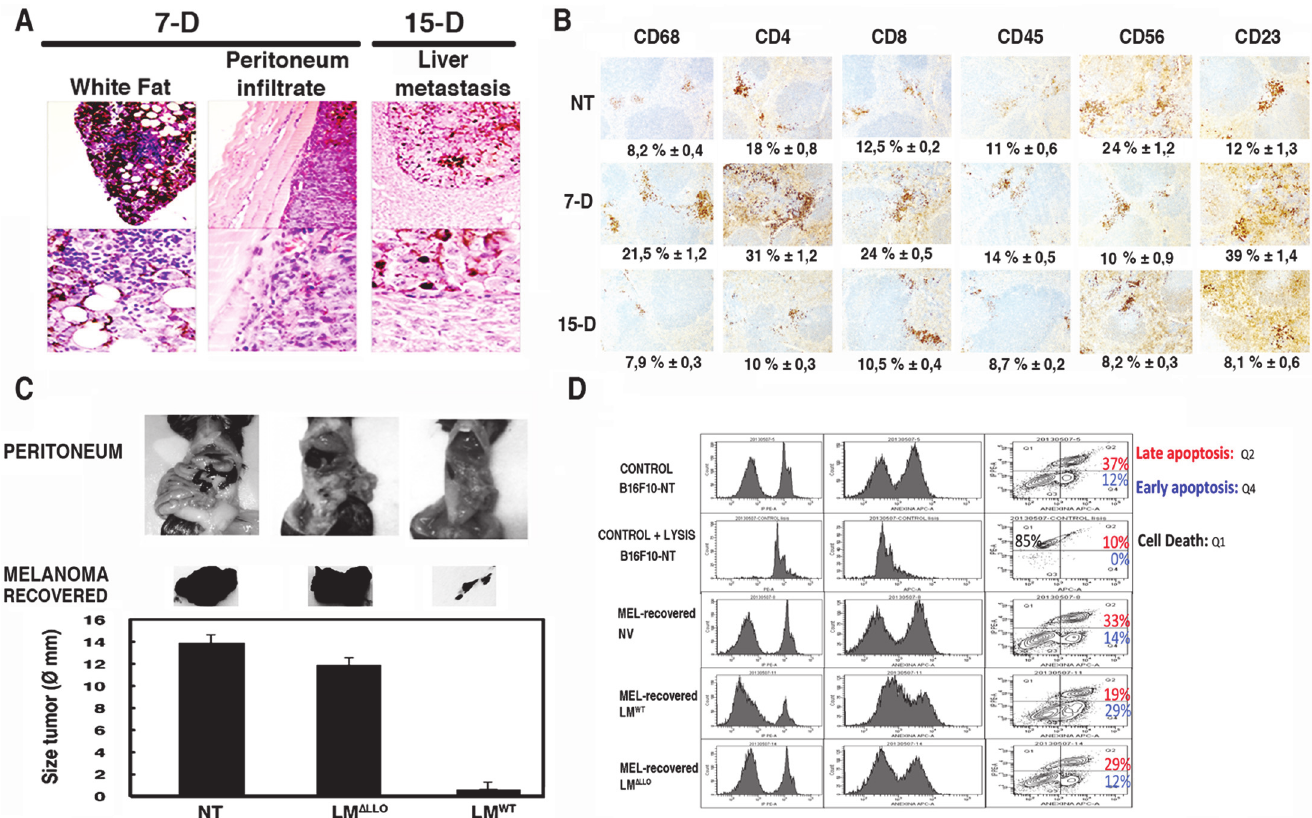
Fig 2. Listeria vaccination of melanoma shows a dual action, tumour regression by apoptosis and bacterial clearance. A , C57BL/6 female were inoculated i . p . with 5 x 10 5 B16F10/mice (n = 5) for 7 (7-D) or 15 days (15-D). Mice were bled, sacrificed and treated for histological analysis as described in Material and Methods . Images correspond to sections of peritoneum infiltrates or liver metastases. B , C57BL/6 female were inoculated i . p . with 5 x 10 5 B16F10/mice (n = 5) as in A for none (NT), 7 (7-D) or 15 days (15-D). Spleens from sacrificed mice (n = 5) were stained for histological analysis using different antibodies as described in Material and Methods and images correspond to sections. Results are expressed as percentages of positive cells (mean ± SD) ( P < 0.05). C , C57BL/6 female were inoculated i . p . with 5 x 10 5 B16F10/mice (n = 5) for 7 days and next injected i . p . or not (NT) with 5 x 10 3 bc/mice of different LM strains (LM WT or LM Δ LLO ) for 5 additional days. Mice were sacrificed, bled to collect sera and photographed before collecting melanoma and lungs. Images correspond to the peritoneum of mice and the recovered melanoma. Plots correspond to measurements of diameters of collected melanoma. Results are expressed as the mean ± SD ( P < 0,05). D , Melanoma recovered from LM WT or LM Δ LLO vaccinated mice or from non-vaccinated mice (NV) as in C were analysed for early and late apoptosis by FACS according to Materials and Methods after double staining with 7-AAD (IP labelled) and annexin V (anexina labelled). Results are expressed as the percentages of late apoptotic cells, necrotic death, (Q2 area corresponding to double positive for 7-AAD and annexin V cells) and the percentages of early apoptotic cells, programmed cell death (Q4 area corresponding to annexin V positive while 7-AAD negative cells) (mean ± SD) ( p <